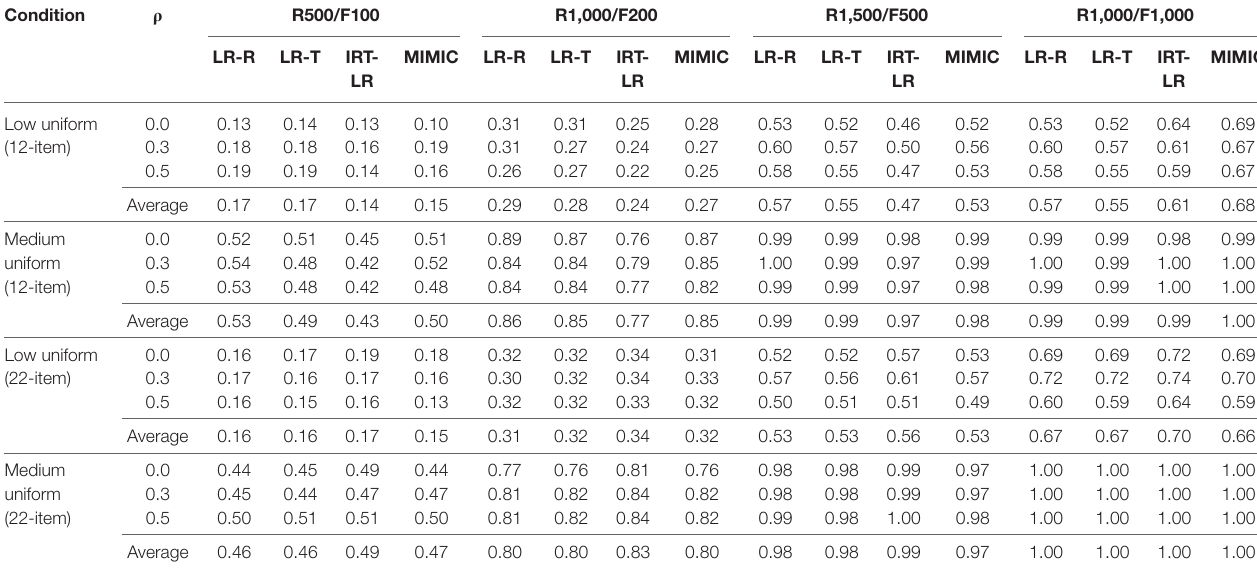
tABLe 3 | Rejection rates in detecting non-uniform differential item functioning (DIF). Condition